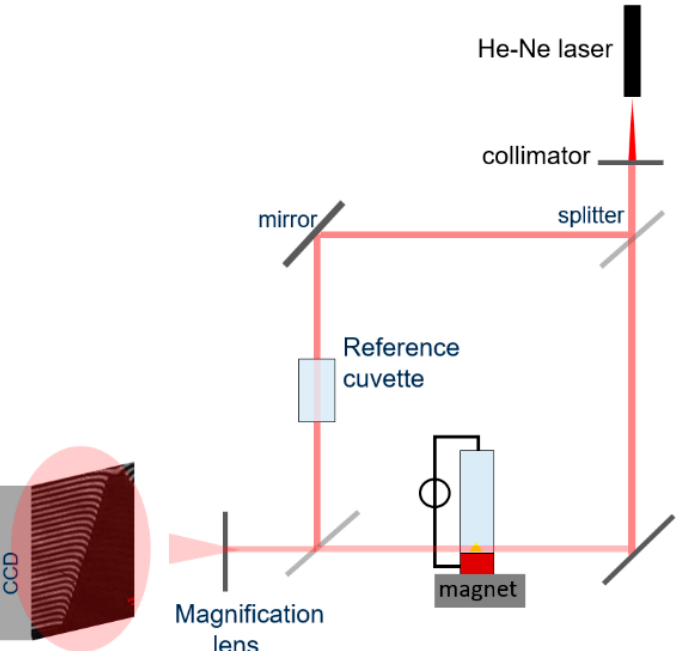
Figure 3. Schema of the Mach–Zehnder interferometer used in the experiment. The position of the electrochemical cell is shown.